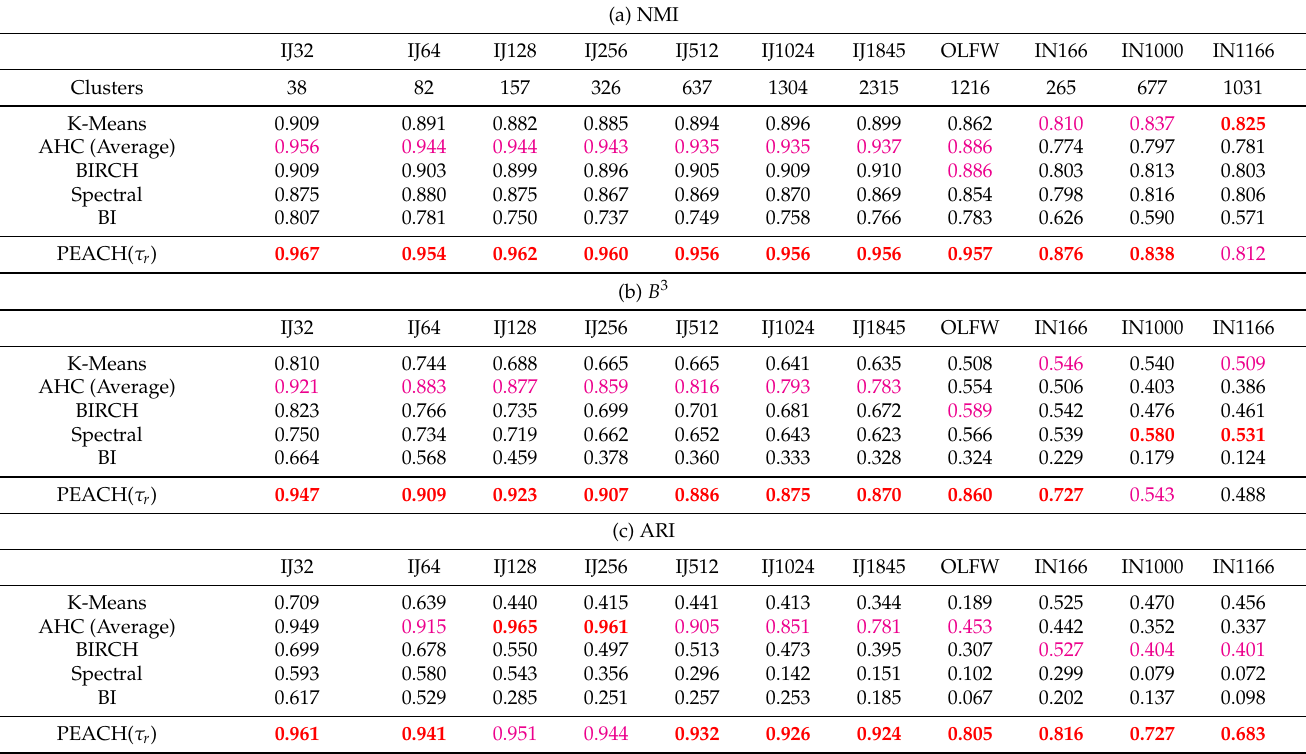
Table 9. Utilizing Robust Number of Clusters. These tables show NMI, B 3 , and ARI results for various classic algorithms when using the number of clusters as defined by our robust threshold estimation τ r . We mark the second-best and best results